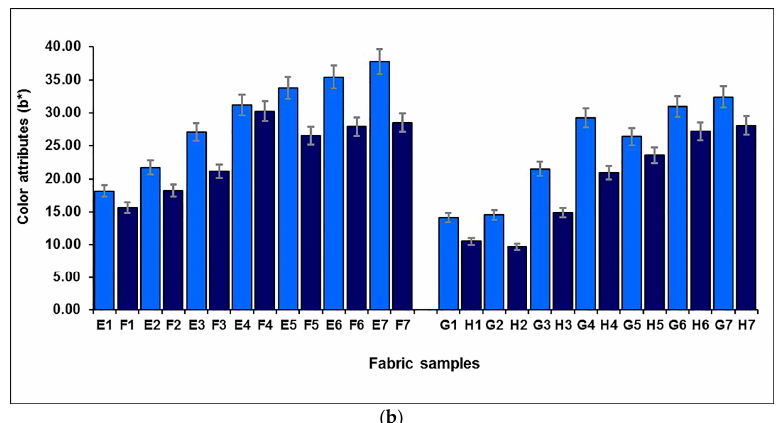
Figure 12. Effect of weft density on the blueness and yellowness of ( a ) blue-red mixed fabrics; ( b ) yellow-green mixed fabrics.